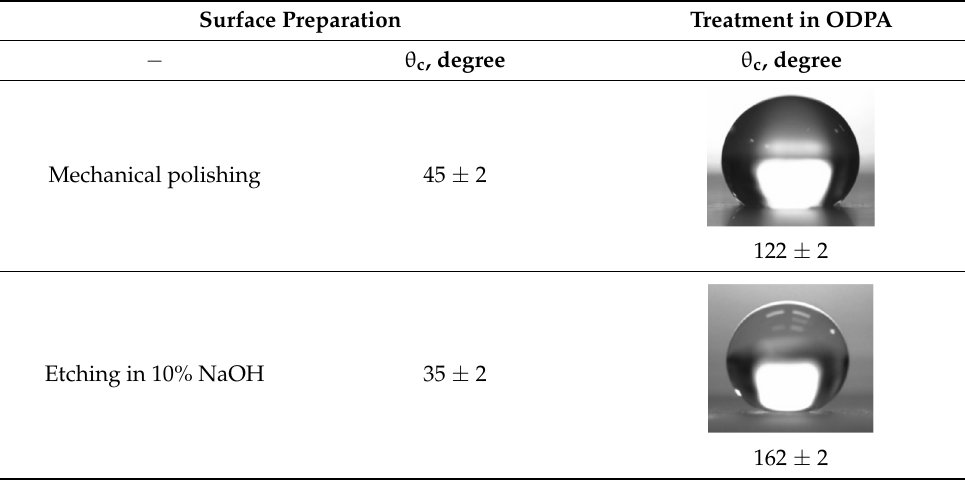
Mechanical polishing 45 ± 2